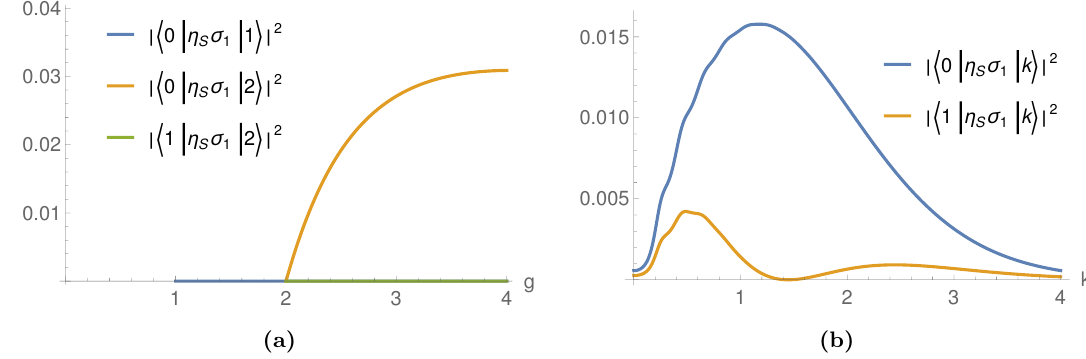
Figure 1. Matrix elements for the operator η S σ 1 between the eigenstates of H 0 with fermion interacting with the φ 4 wobbling kink. We fix g = 1 . 6 in